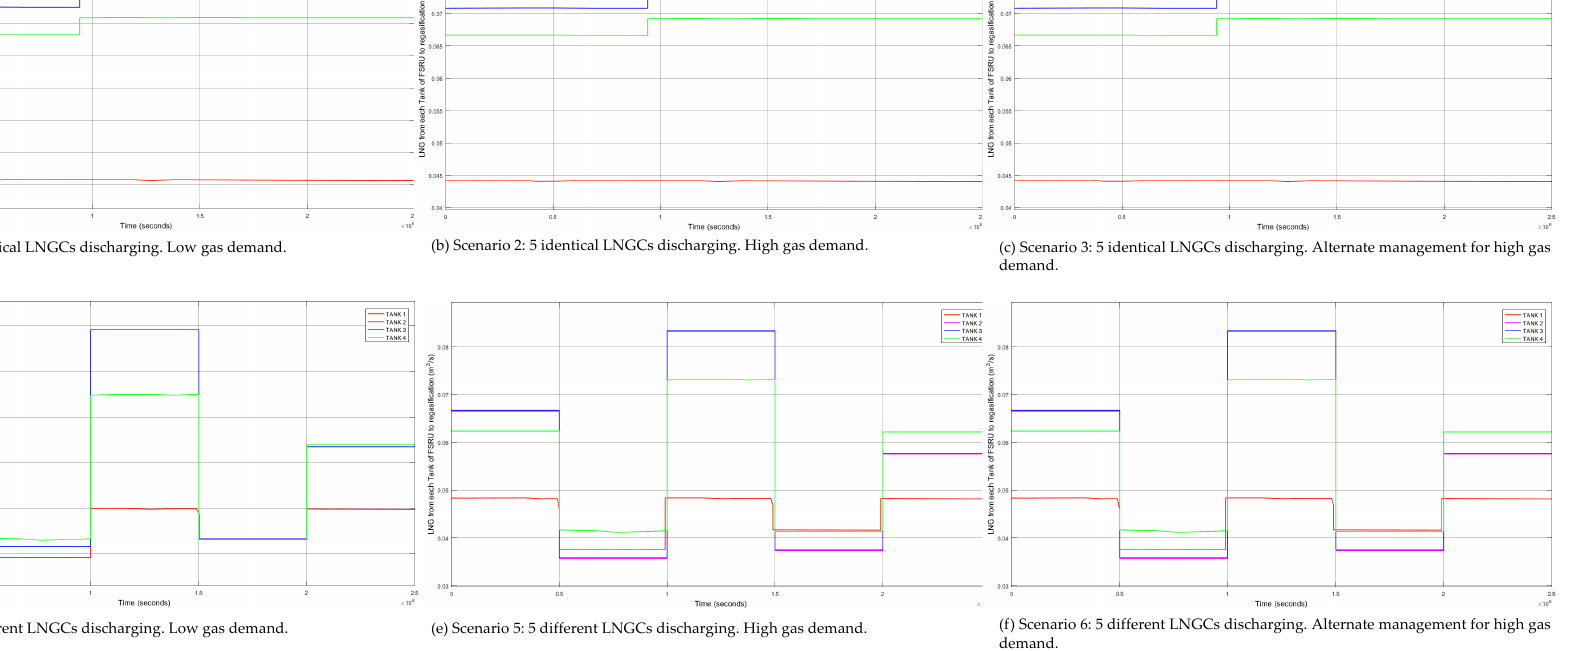
Figure 7. LNG pumped to the vaporizer of the FSRU for di ff erent operation